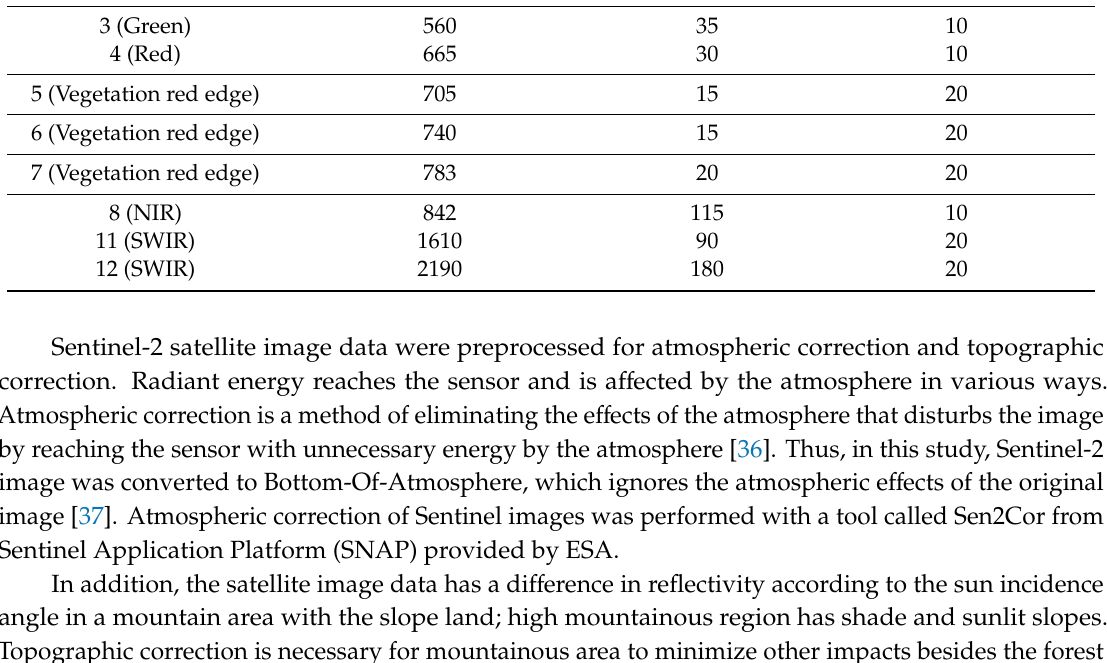
Table 2. Definition of Sentinel-2 spectral bands used in this study [36].